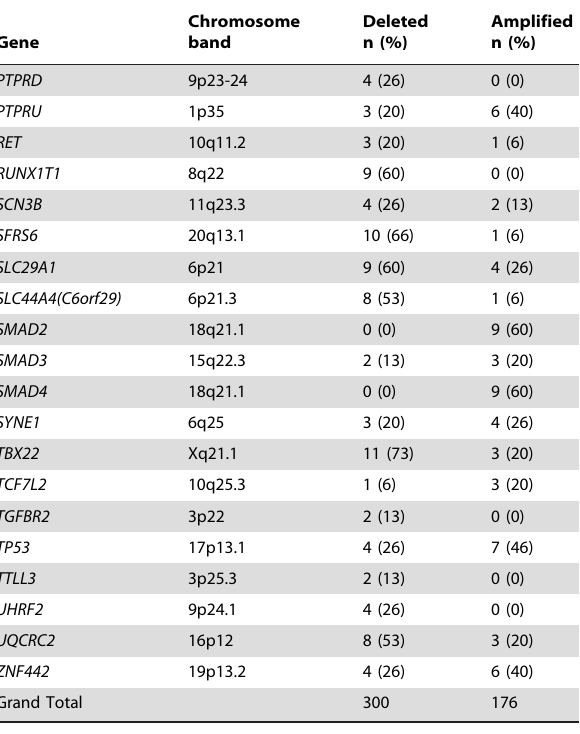
Table 3. Status of the 68 genes from Sjo¨blom et al. list (23) in the subjects of this